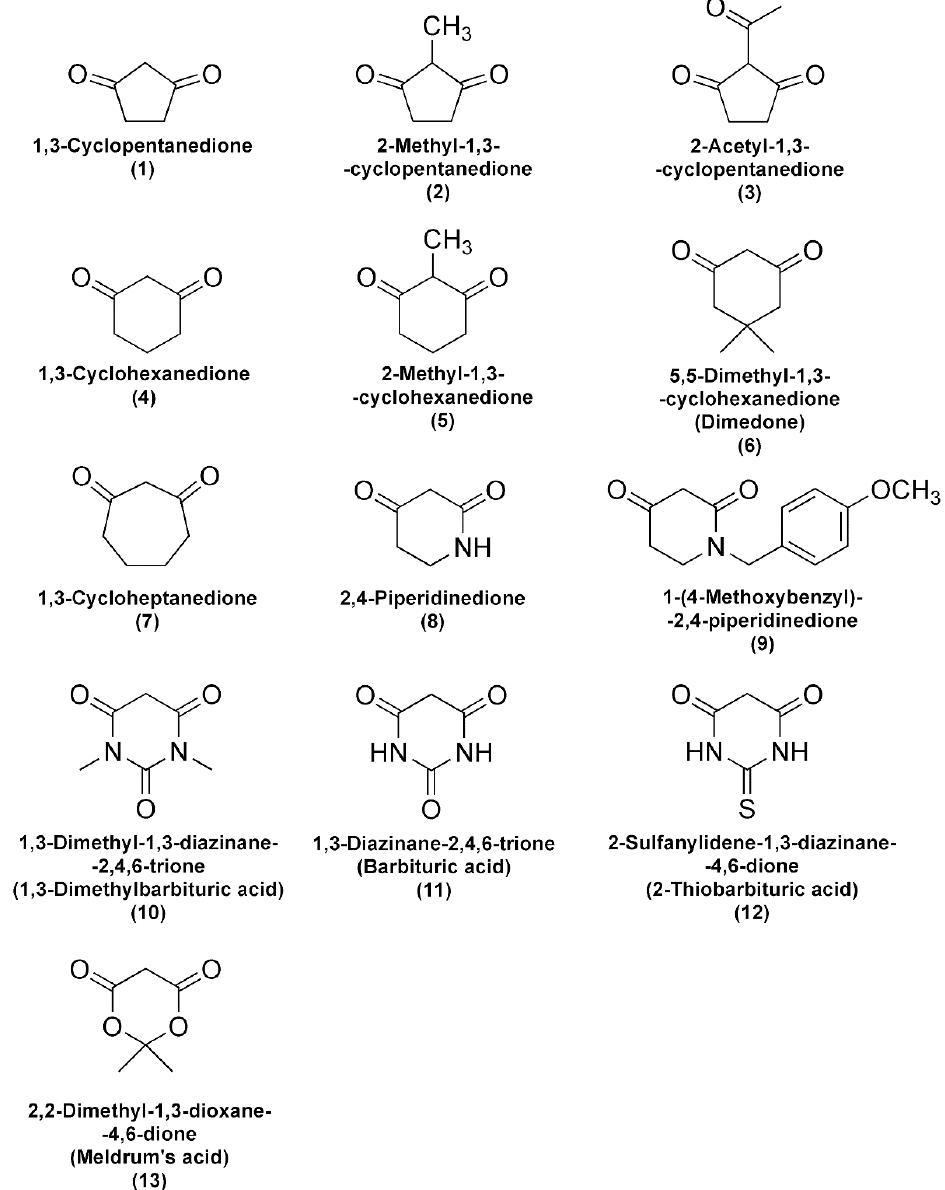
Table 1. Values of the k S / k O2 ratio (average values from at least three independent experiments; pH 7.4, 25 °C) for the studied cyclic C -nucleophiles, with the rate constants for their reactions with HNO and theoretically calculated Gibbs free energy barriers at the B2PLYP-D3/6-311+(2df,2p) theory level.